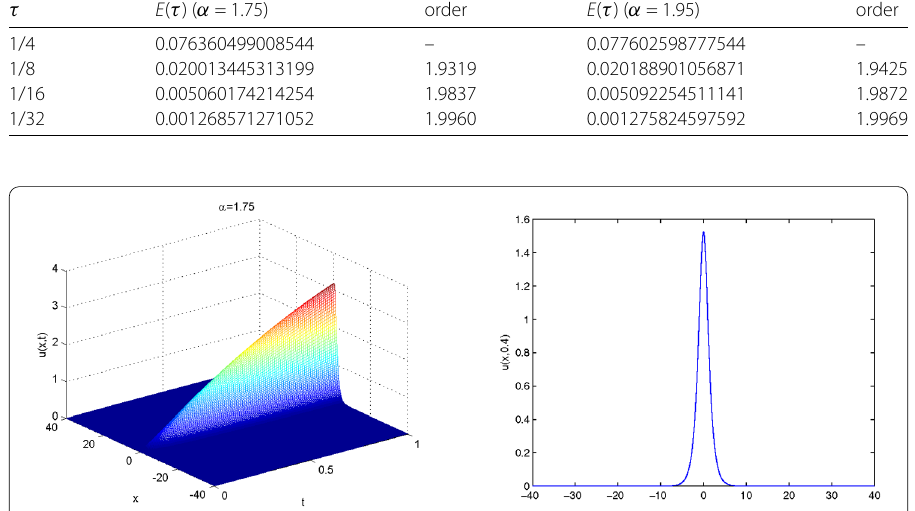
Figure 1 The numerical solution of the initial boundary value problem in Example 1 with α = 1.75, h = 1/16, τ = 1/200 and corresponding solution for u ( x , t ) when t =